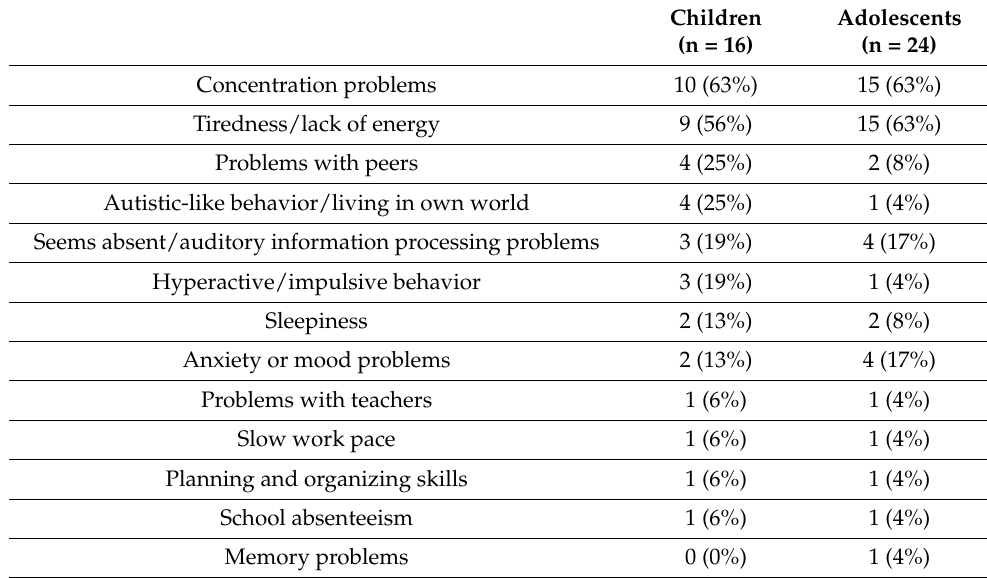
Table 3. The three most frequently reported problems by teachers in patients with NT1.